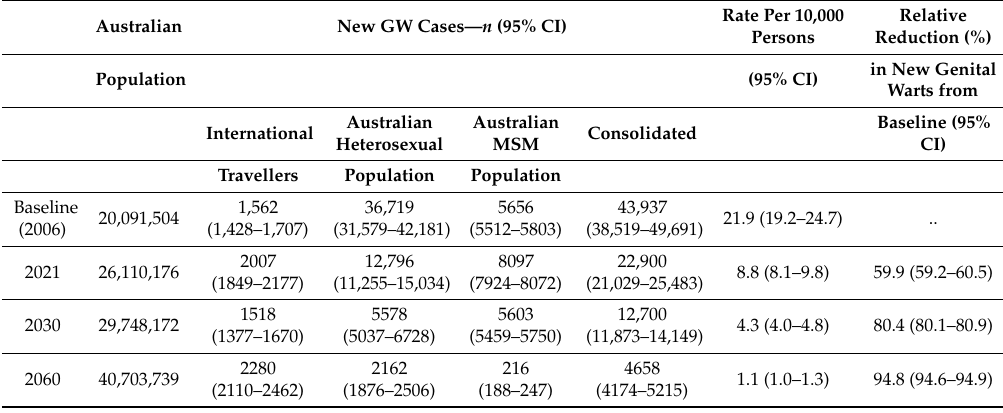
Table 5. Revised estimates for number and relative reduction in new genital warts consults in Australia, after adjusting for the ongoing transmission due to importation of genital warts (consolidated cases including Australian residents and international